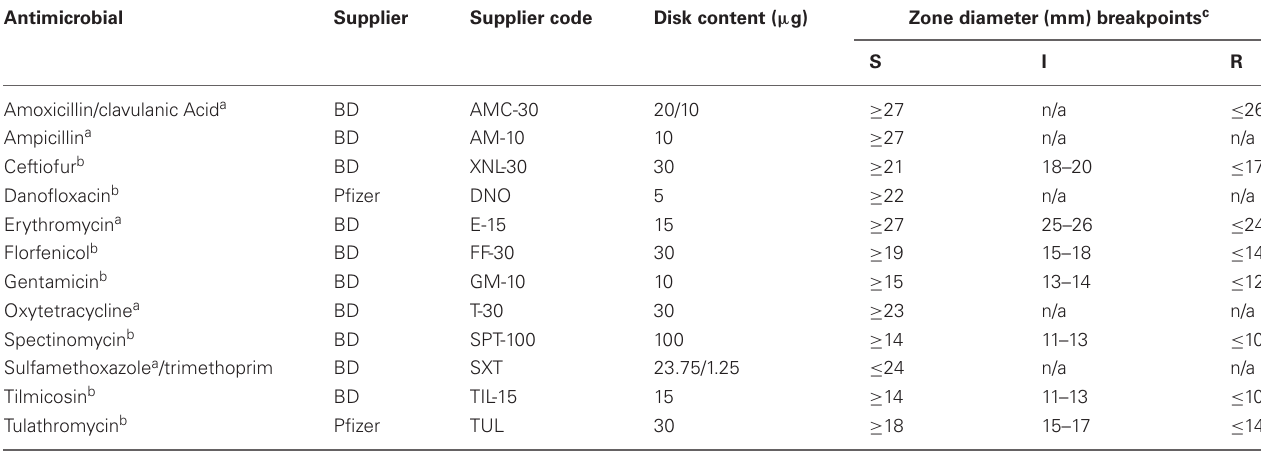
Table 1 | Antimicrobial agents, suppliers, disk contents, and interpretative criteria used for disk susceptibility testing.